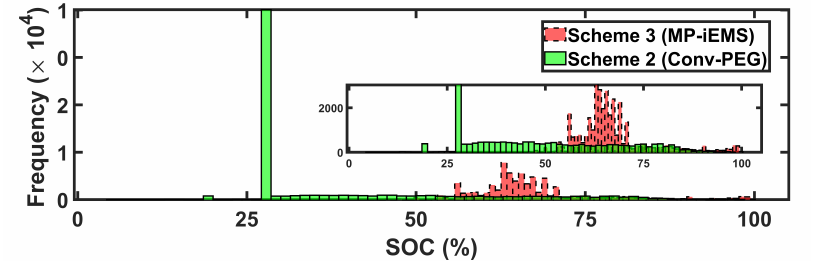
Figure 17. Histogram of EV storage